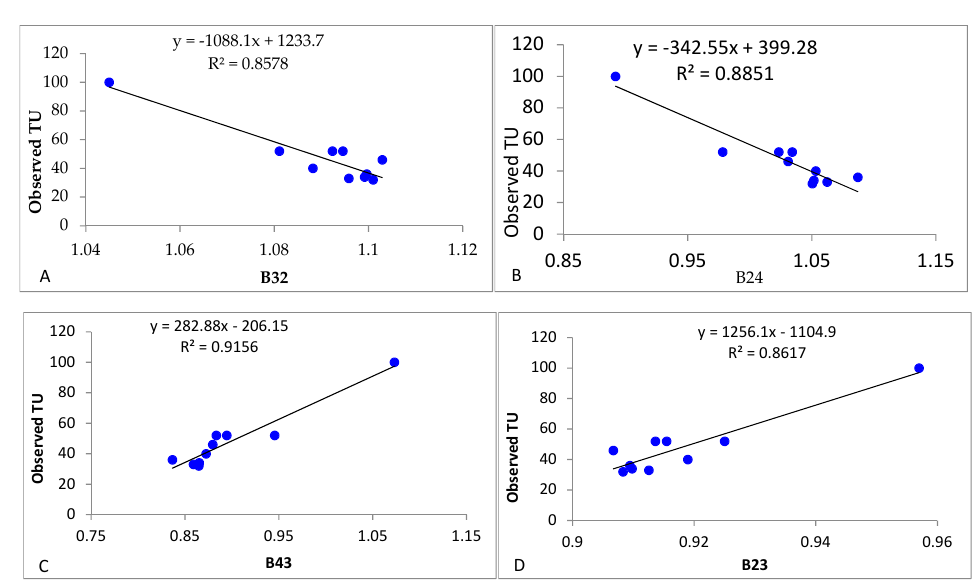
Figure 5. Turbidity and Sentinel-2 band ratio analysis. ( A ) Observed and estimated (band ratio B3/B2) turbidity. ( B ) Observed and estimated (band ratio B2/B4) turbidity. ( C ) Observed and estimated (band B4/B3) turbidity. ( D ) Observed and estimated (band ratio B2/B3) turbidity.